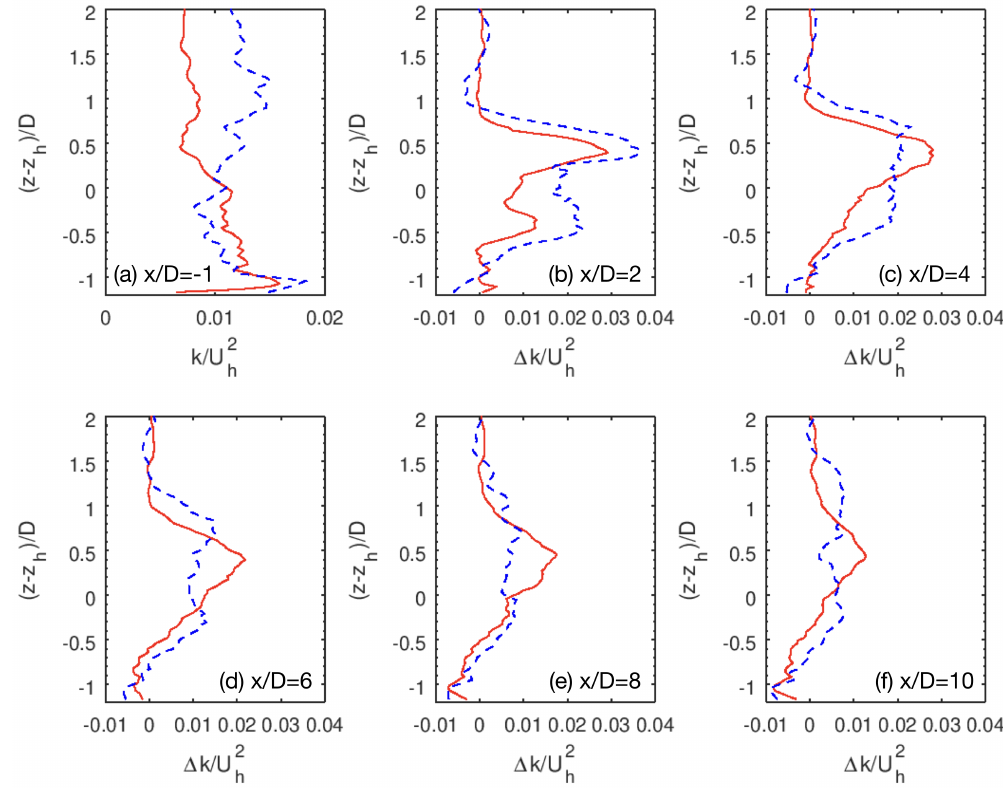
Figure 9. ( a ) Vertical profiles of turbulence kinetic energy at 1 D upwind of the turbine; ( b – f ) Vertical profiles of turbine-added turbulence kinetic energy at different locations downwind of the turbine. Red lines: T80; Blue lines: